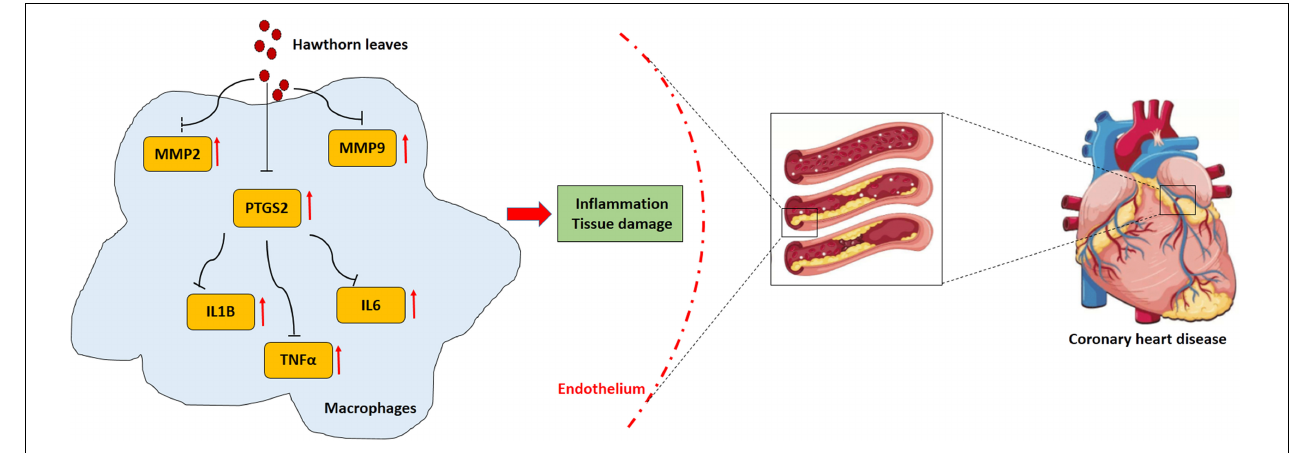
FIGURE 8 | The working model shows the mechanism of hawthorn leaves against